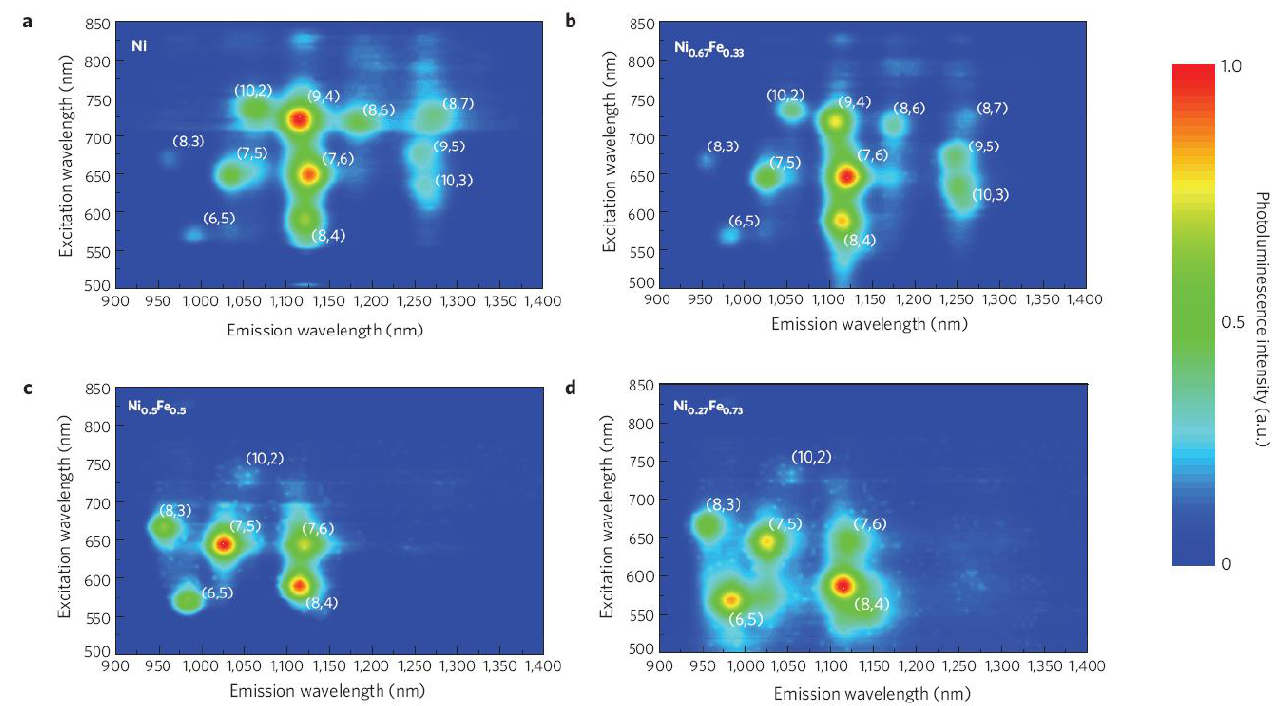
Figure 6. The contour plot maps of the PL intensity obtained for the SWCNT samples synthesized with different catalysts: ( a ) Ni, ( b ) Ni 0.67 Fe 0.33 , ( c ) Ni 0.5 Fe 0.5 , and ( d ) Ni 0.27 Fe 0.73 . The chiral indices are indicated near the corresponding peaks [41].